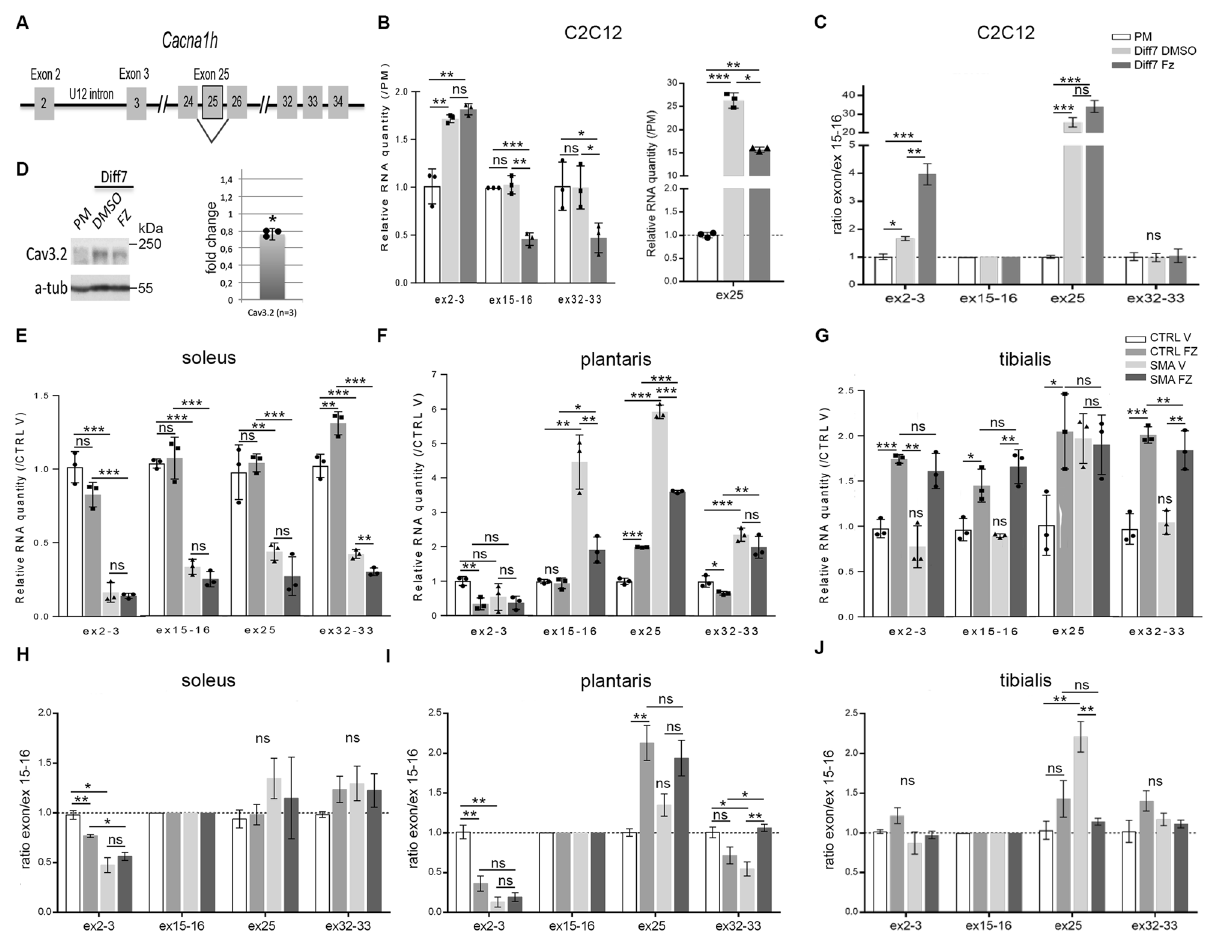
Figure 3. Effects of flunarizine on the expression and splicing profile of Cacna1h gene in C2C12 myotubes and skeletal muscles of SMA model mice. ( A) Schematic representation of the U12-intron flanked by exon 2 and 3 (ex2-3) and the alternative spliced exon 25 of Cacna1h gene is shown. ( B) RT-qPCR analysis of the RNA levels of ex2-3, ex15-16, ex25 and ex29-30 exons of Cacan1h gene is performed in C2C12 myotubes compared to myoblast in proliferation medium (PM). ( C) The expression ratios between exons and ex15-16 RNA levels, ex15-16 being present in all Cacna1h mRNAs. Total RNA is prepared from C2C12 myoblasts grown in proliferating medium (PM) or after 7 days in differentiation medium (Diff7) with either DMSO or flunarizine (FZ) for the last 16 h. ( D) Immunoblot analysis of the Cacna1h encoded protein Cav3.2 confirms a significant 20% reduction of the protein levels in total protein extracts of C2C12 myotubes by flunarizine (n = 3). Uncropped images are found in supplemental Fig. 3. ( E–G ) RNA levels of Cacan1h exons are determined at P10 in the soleus, plantaris and tibialis, respectively. ( H–J ) Expression ratios between exons and ex5-6 RNA levels are calculated for the soleus, plantaris and tibialis, respectively. Error bars represent SD from the mean values of triplicates from 3 independent experiments with C2C12 cells and 3 mice per group. NS, not significant (P > 0.05), *P < 0.05, ** < 0.01, ***P < 0.001. Student’s of T-type calcium channels Ca v 3.1, Ca v 3.2 and Ca v 3.3 encoded by Cacna1g , Cacna1h and Cacna1i genes, respectively 44 , we then investigated whether the drug could modulate Cacna1h expression. Of note, Cacna1g and